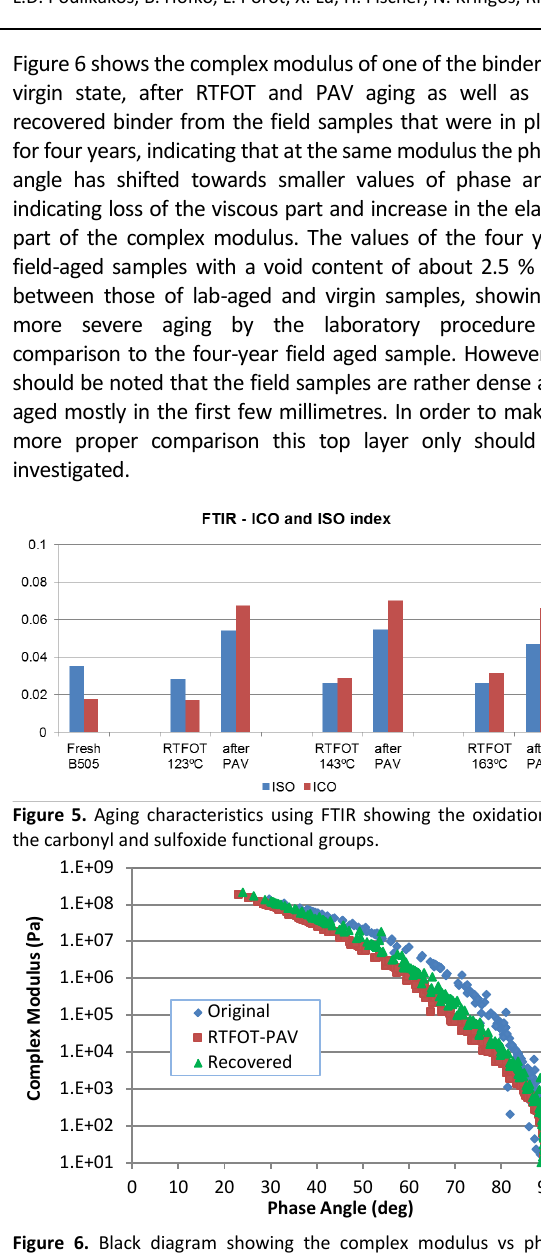
Figure 6. Black diagram showing the complex modulus vs phase angle of original binder laboratory aged (RTFOT+PAV) and recovered field